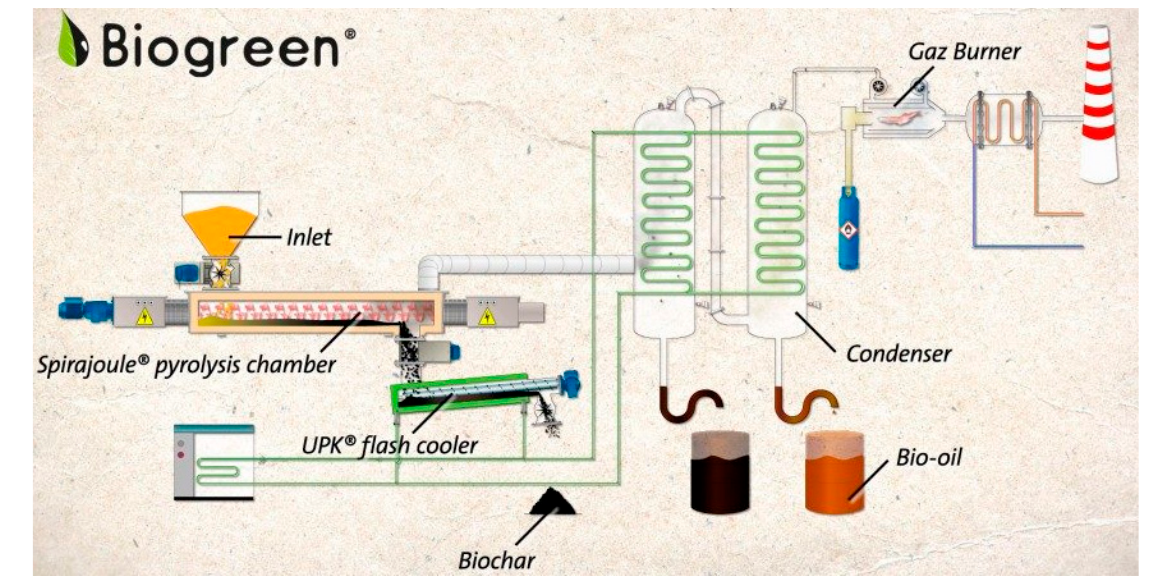
Figure 18. Scheme of the ETIA “ Biogreen ” installation for biomass pyrolysis [150].